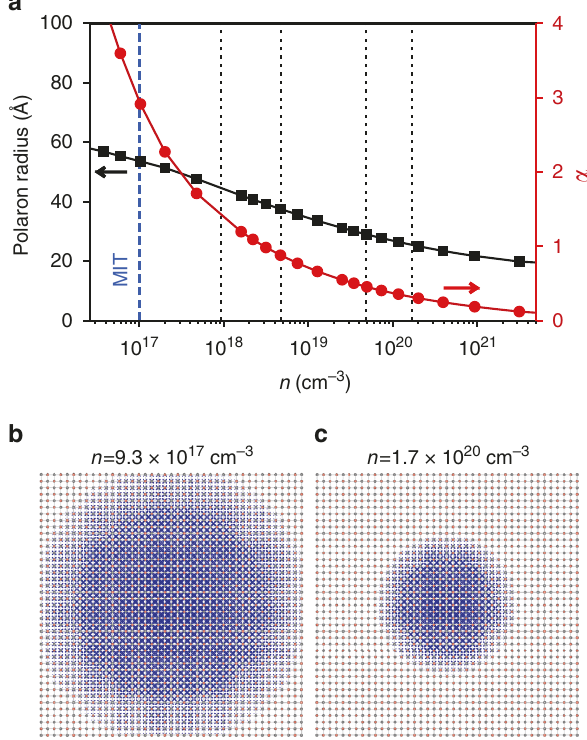
Fig. 5 Plasmonic polaron structure. a Evolution of the electron − plasmon coupling constant α (red symbols) and of the plasmonic polaron radius (black symbols) with carrier density. The black-dashed lines indicate the experimental doping levels from Fig. 3, while the blue line marks the critical density at the metal-insulator transition. b , c Square modulus of the polaron wavefunction for n = 9.3×10 17 cm − 3 ( b ) and n = 1.7×10 20 cm − 3 ( c ). For clarity the wavefunctions are represented only in the xz plane, with 20 replicas of the unit cell shown along each